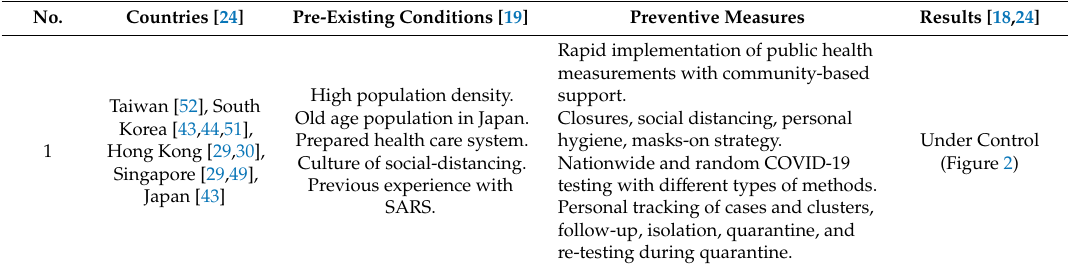
Table 1. Countries, their markers, some public health measures, and outcomes during the COVID-19 pandemic.